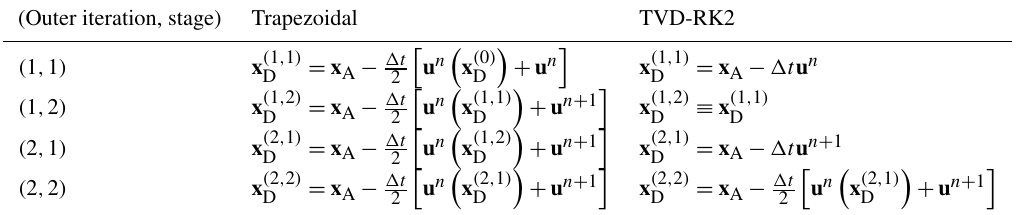
Table 2. Comparison of the departure point calculations as described in Wood et al. (2014) (Trapezoidal) and as used in GA6.0 (TVD-RK2). Subscripts A and D denote the arrival (grid) and departure points respectively. (Outer iteration, stage)